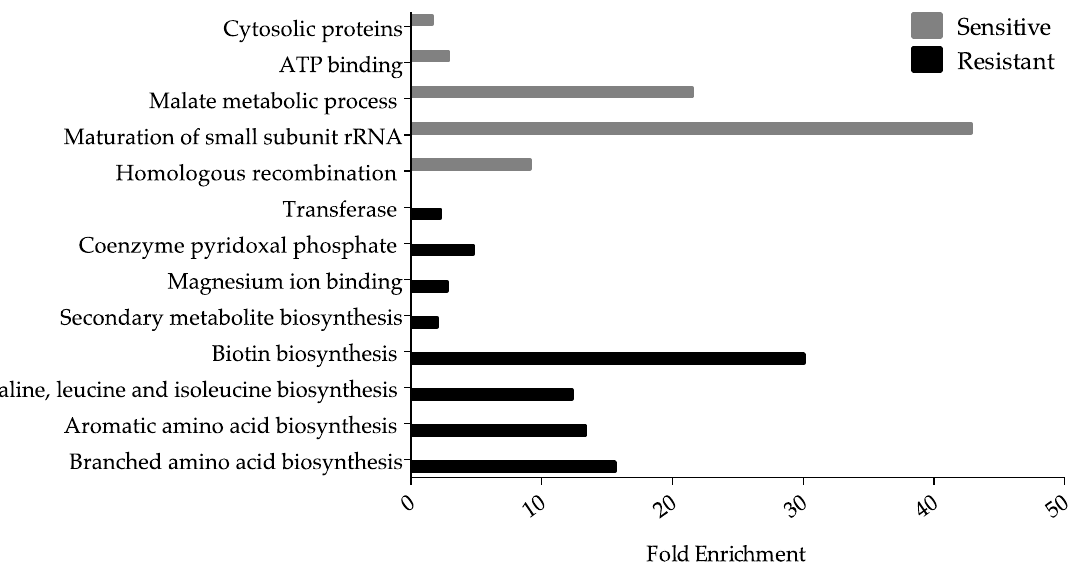
Figure 3. Functional enrichment among the Ga-resistant and -sensitive gene hits. The DAVID gene functional classification (version 6.8) database, a false discovery rate of 10% and a cutoff score two standard deviations from the mean was used to measure the magnitude of enrichment of the selected gene hits against the genome of E. coli K-12. Only processes with gene hits ≥ 3 were included.